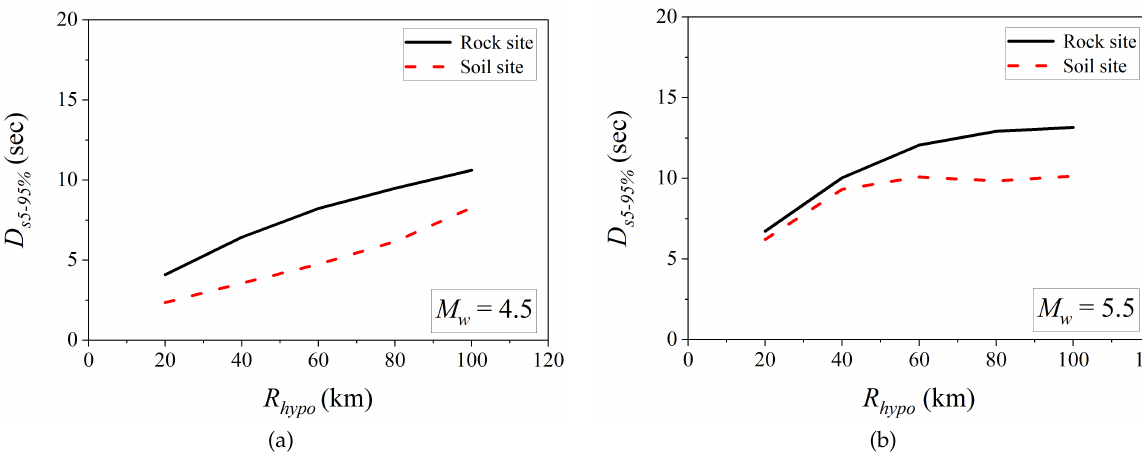
Fig. 12. Comparison of D s 5 − 95% between rock and soil sites for (a) M w = 4.5, and (b) M w =